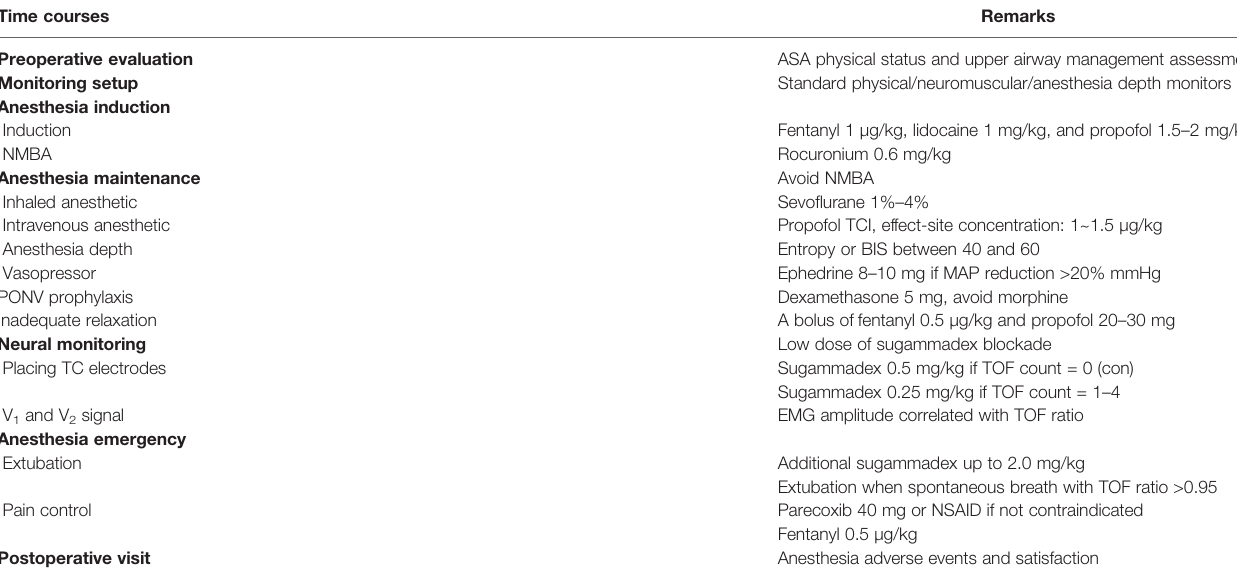
TABLE 1 | Departmental anesthesia protocol for intraoperative neuromonitoring during thyroid